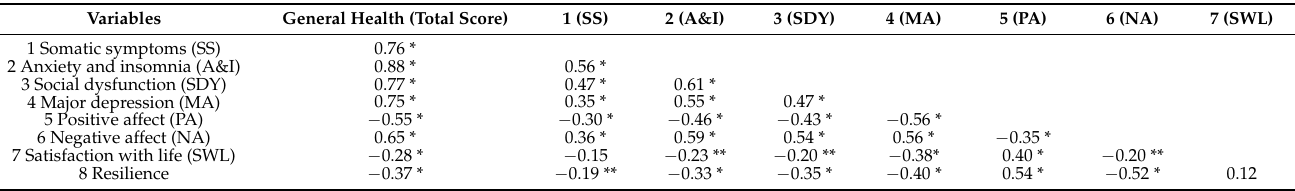
Table 2. Correlations between variables